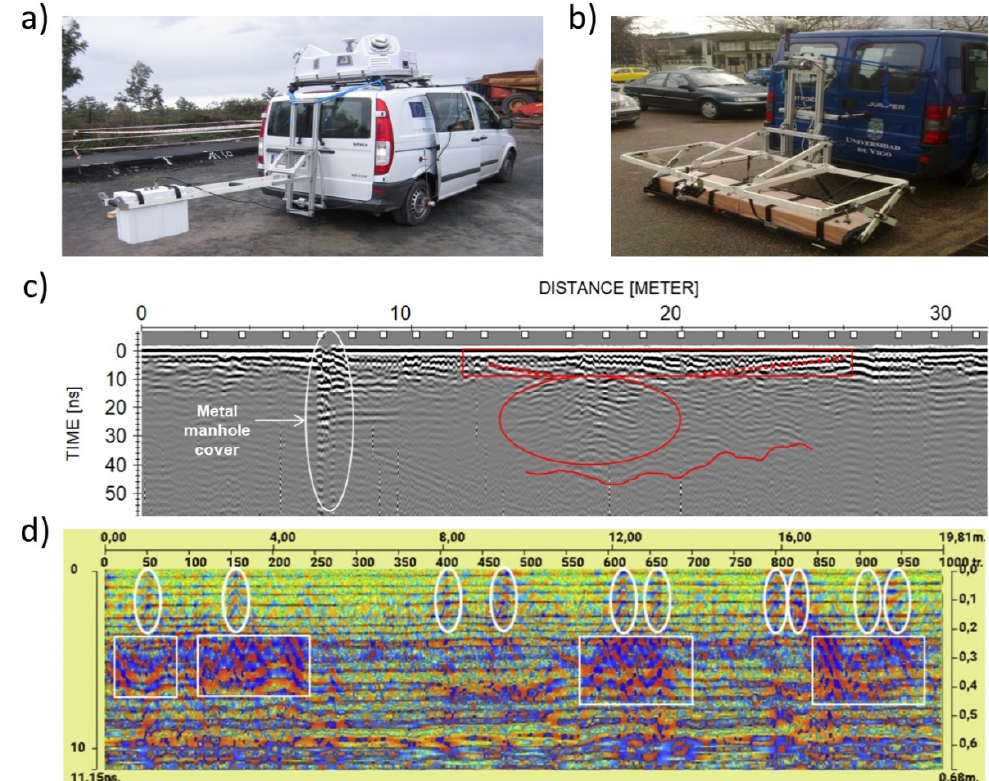
Figure 6. GPR. ( a ) Air-coupled system, ( b ) array multi-channel (ground coupled) system, ( c ) 500 MHz radargram showing reinforcement settlement (red rectangle) and early sinkhole (red ellipse), and ( d ) 1 GHz radargram showing both surface cracks (white ellipses) and embedded cracks (white rectangles) [122].